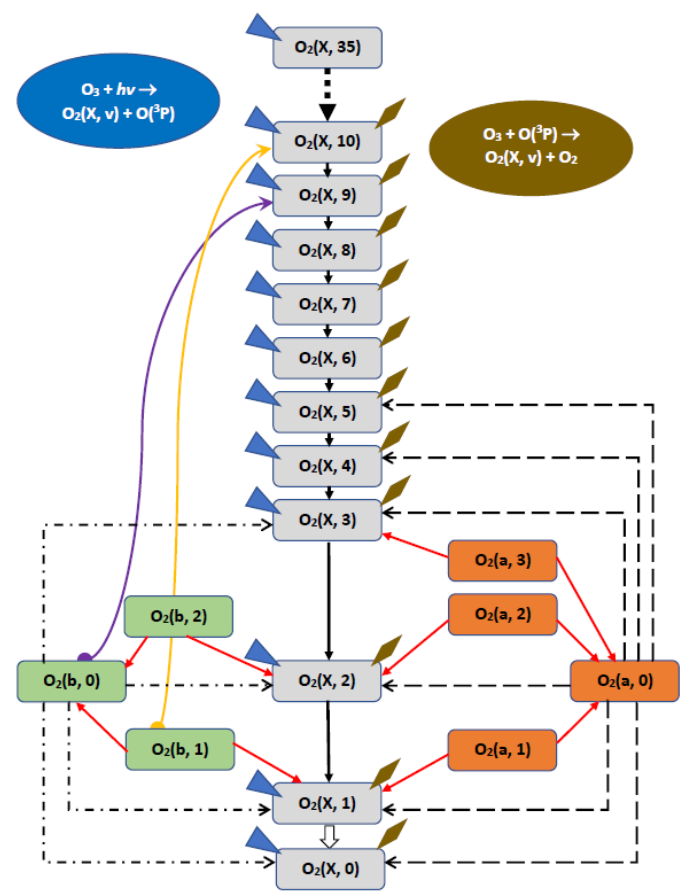
Figure 9. The block-diagram of the population of O 2 (X 3 Σˉ g , v = 1–35) levels in the mesosphere and lower thermosphere, according to YM2011 model (version 2019). A brief notation of levels: O 2 (X, v) = O 2 (X 3 Σˉ g , v), O 2 (a, v) = O 2 (a 1 Δ g , v), O 2 (b, v) = O 2 (b 1 Σ g+ , v). Direct sources of formation of O 2 (X, v) molecules are photolysis of ozone in the Hartley, Huggins, Chappuis, and Wulf bands (blue triangle), the reaction O 3 + O( 3 P) → O 2 (X, v ≤ 30) + O 2 (brown rhombus). The dashed-dotted line indicates the quasi-resonant EE’ energy transfer as a result of O 2 (b, 0) + O 2 → O 2 (a, v) + O 2 (X, 3-v); long-dashed lines denote quasi-resonant EV energy transfer as a result of O 2 (a, 0) + O 2 → O 2 (X, v) + O 2 (X, 5-v); red inclined lines - quasi-resonant EV exchange as a result of O 2 (a, v) + O 2 → O 2 (X, v) + O 2 (a, 0) and O 2 (b, v) + O 2 → O 2 (X, v) + O 2 (b, 0) for the first and second singlet states of the oxygen molecule. The black vertical arrows are the relaxation processes of the O 2 (X, v) levels in the reactions O 2 (X, v) + O 2 → O 2 (X, v-1) + O 2 (X, 1), O 2 (X, v) + O 2 → O 2 (X, v-1) + O 2 (X, 0), O 2 (X, v) + O( 3 P) → O 2 (X, v-Δv) + O( 3 P) and O 2 (X, v) + N 2 → O 2 (X, v-2) + N 2 (X, 1). The wide non-solid arrow for O 2 (X, 1) denotes VT quenching of O 2 (X, 1) + M → O 2 (X, 0) + M, where M = O 2 , N 2 , O( 3 P). The quasi-resonant reactions that we hypothesized are indicated by curved lines: violet is for the reaction O 2 (b, 0) + N 2 → O 2 (X, 9) + N 2 , yellow is for the reaction O 2 (b, 1) + O( 3 P) → O 2 (X, 10) + O( 3 P) (see Table 2).